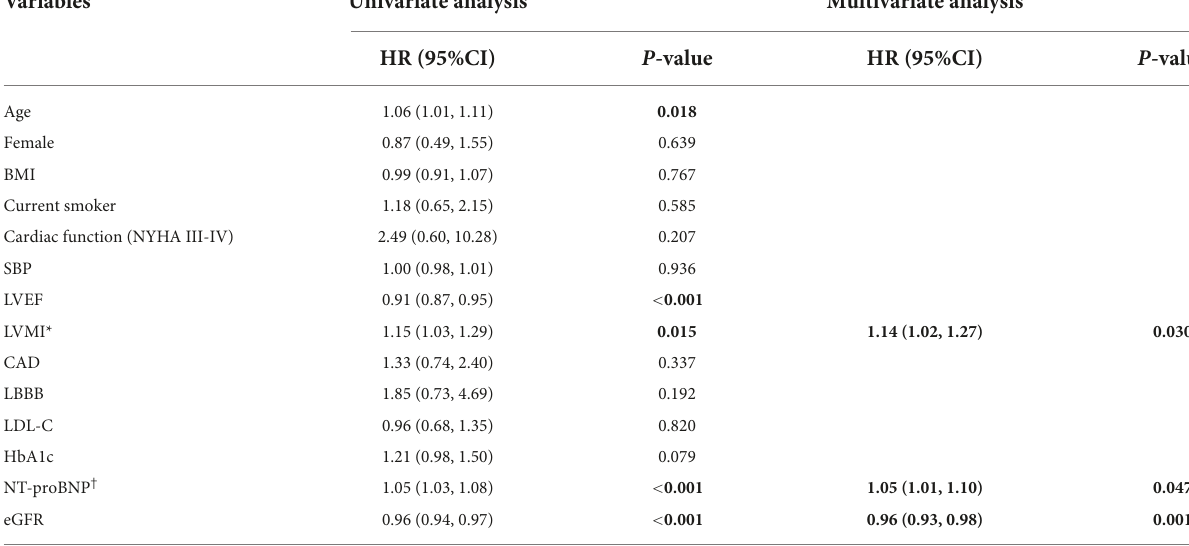
TABLE 3 Univariate and multivariate cox regression analyses for the association between variables and HF readmission. Variables